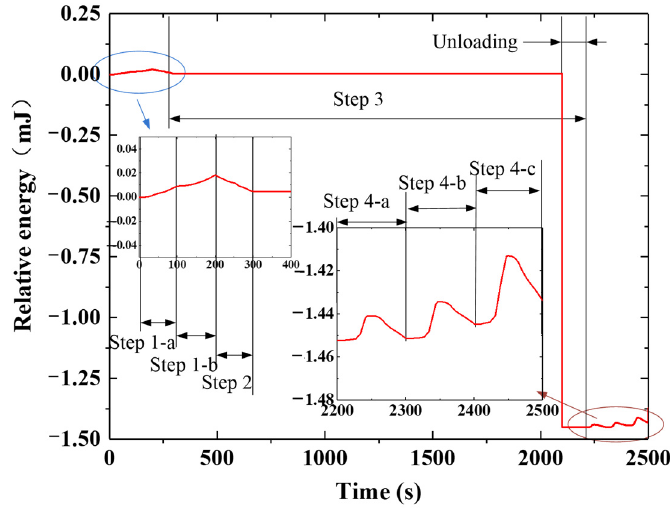
Figure 25. Response stress diagram of the F-DS with distributed drive.